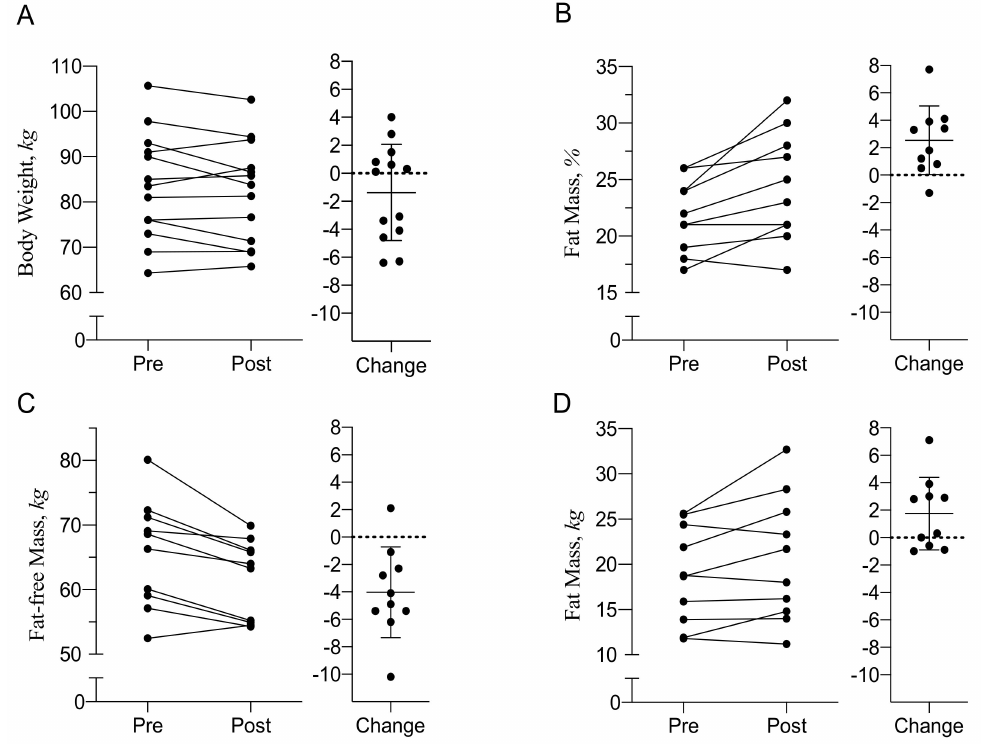
Figure 1. Changes in Body Weight and Body Composition after 10-Week Deployment on a Submarine. Individual changes in body weight ( A , n = 13) and body composition ( B – D , n = 10) before and after 10-week deployment on a submarine are presented. The changes are also presented as mean ± SD. Skinfold thickness increased by 14 ± 13 mm during deployment (35%, p = 0.002, estimated fat mass: + 3.3 ± 2.9%, p = 0.001). Most pronounced changes were observed at the iliac crest ( + 8.9 ± 7.8 mm, i.e., + 55%, p = 0.001), in addition, increases at the triceps were significant ( + 1.0 ± 0.4 mm, i.e., 15%, p =